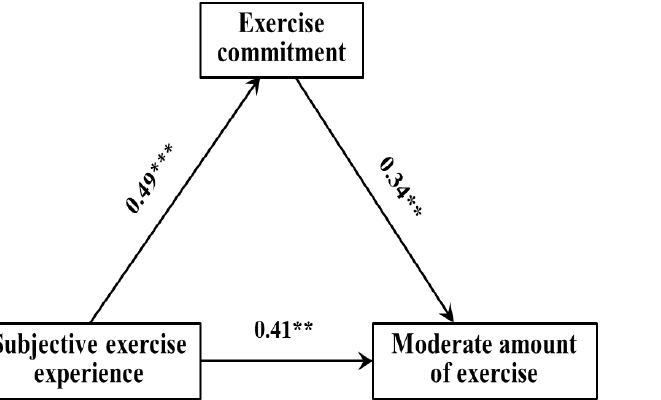
Figure 3. The path model of exercise commitment between subjective exercise experience and moderate exercise amount. ** p < 0.01; *** p < 0.001.